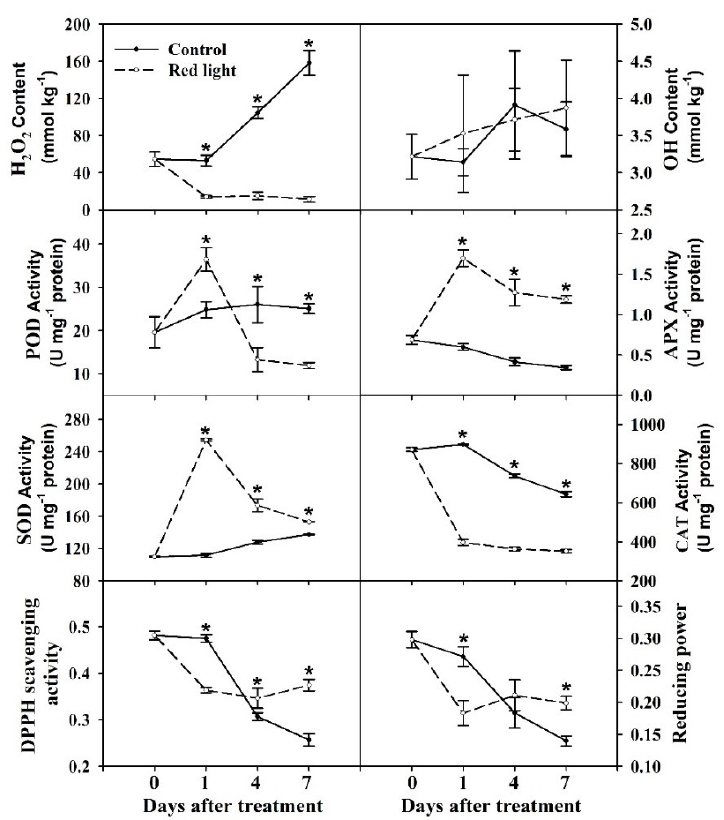
Figure 2. Reactive oxygen species (ROS)-related characters changes after red light irradiation. Mean values and standard errors of four biological replicates were used to draw this graph. The * on the error bars indicated statistically significant differences ( p < 0.05) between control and red light-treated samples.